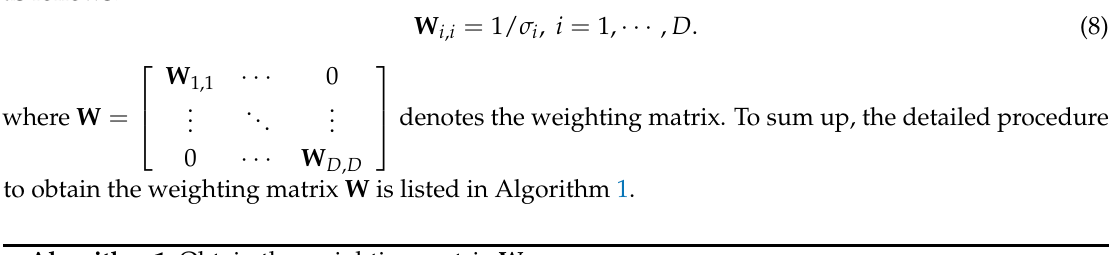
Algorithm 1: Obtain the weighting matrix